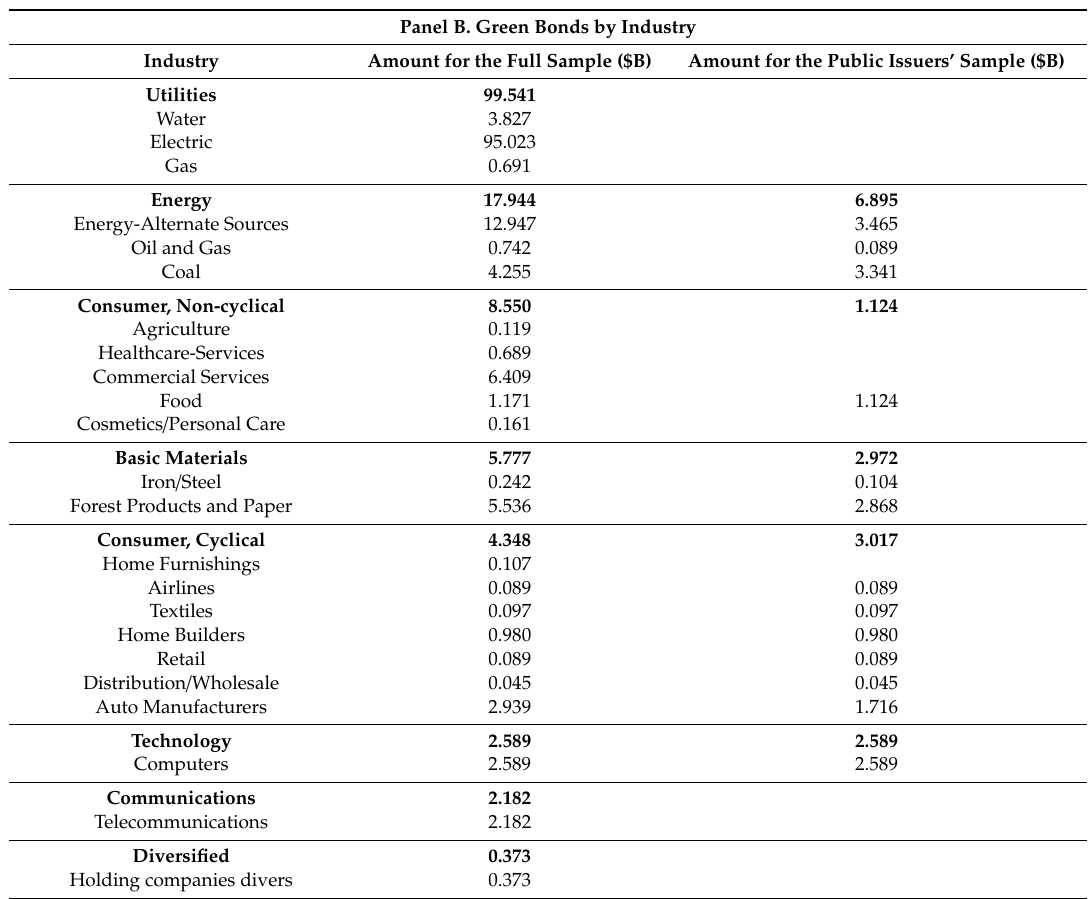
Panel B. Green Bonds by